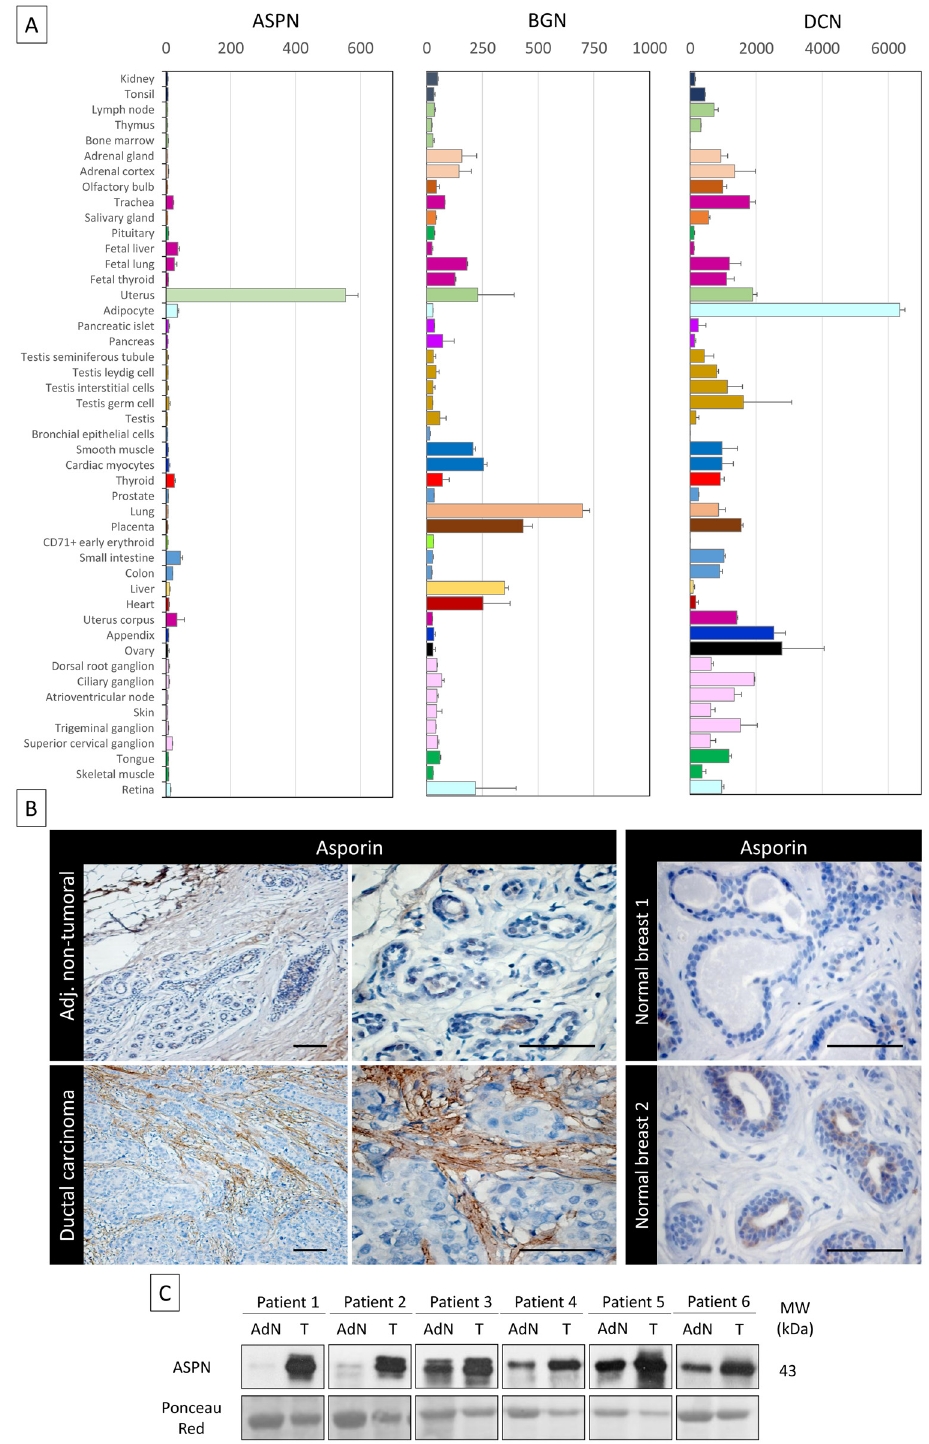
Fig 1. Asporin is overexpressed in breast cancer tissues. (A) Tissue-specific pattern of mRNA expression of asporin (ASPN), biglycan (BGN), and decorin (DCN). Source: BioGPS (http://biogps.org). The data are presented as mean ± standard deviation (SD). (B) Representative IHC staining of asporin expression in ductal carcinoma and adjacent non-tumoral breast tissue (left panel) and normal breast tissue obtained from patients undergoing mammary reduction surgery (right panel). Asporin is almost